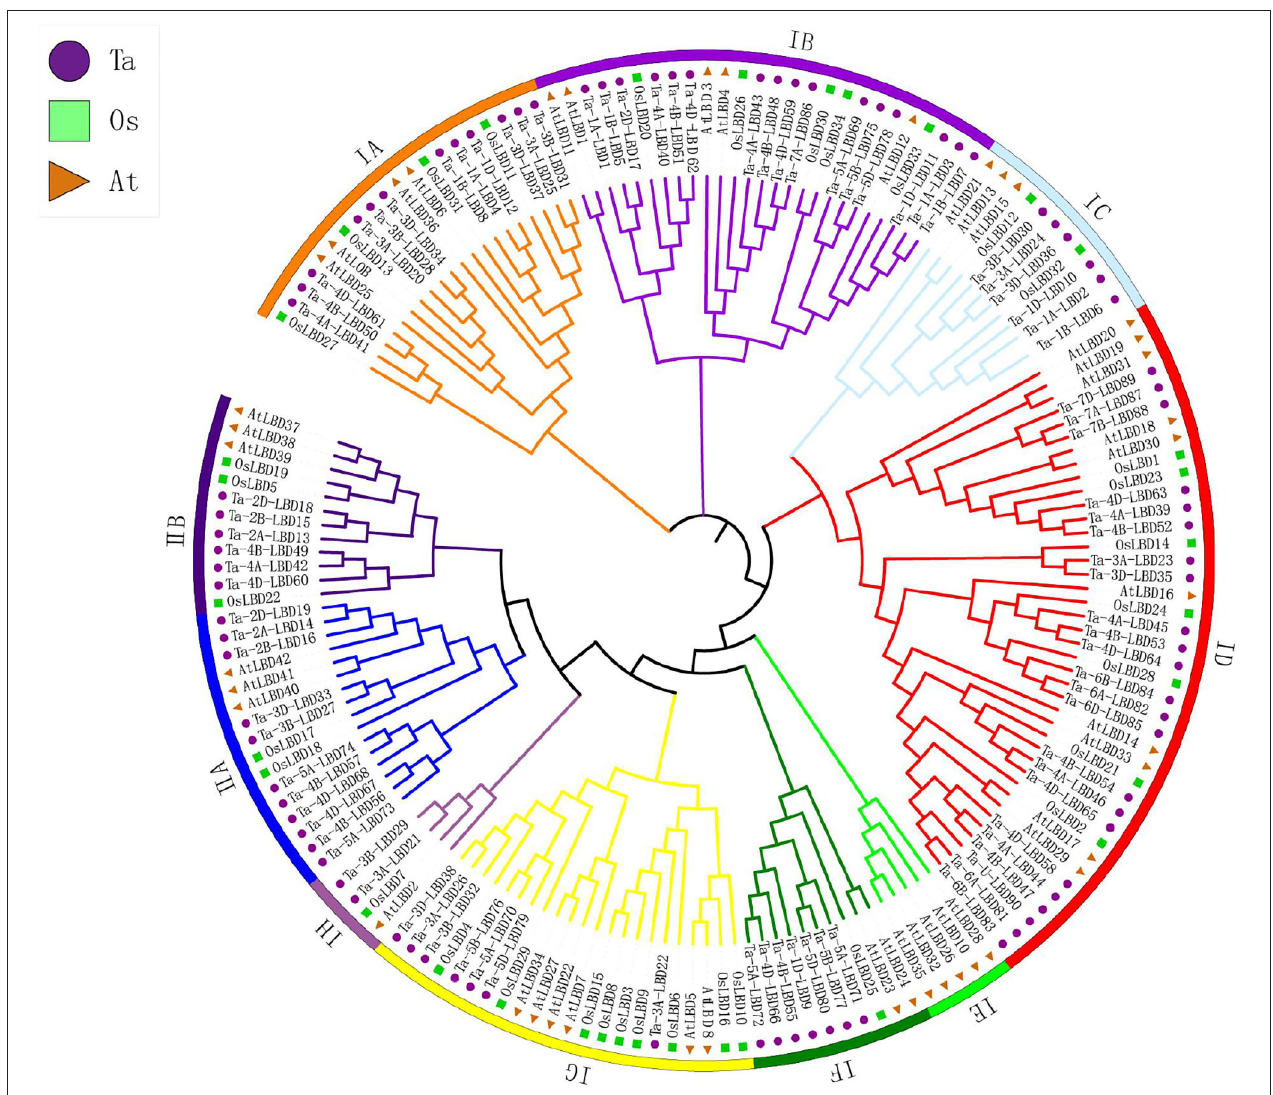
FIGURE 2 | Phylogenetic analysis of LBD gene family in wheat. Tree was constructed by MEGA8.0 using the neighbor-joining method with 1,000 bootstraps. Purple, green, and orange colors represent LBD protein sequences from Triticum aestivum (Ta), Oryza sativa (Os), and Arabidopsis thaliana (At), respectively. The branch length represents the magnitude of genetic change. Different clade colors represent subfamilies, respectively. LBD, lateral organ boundaries